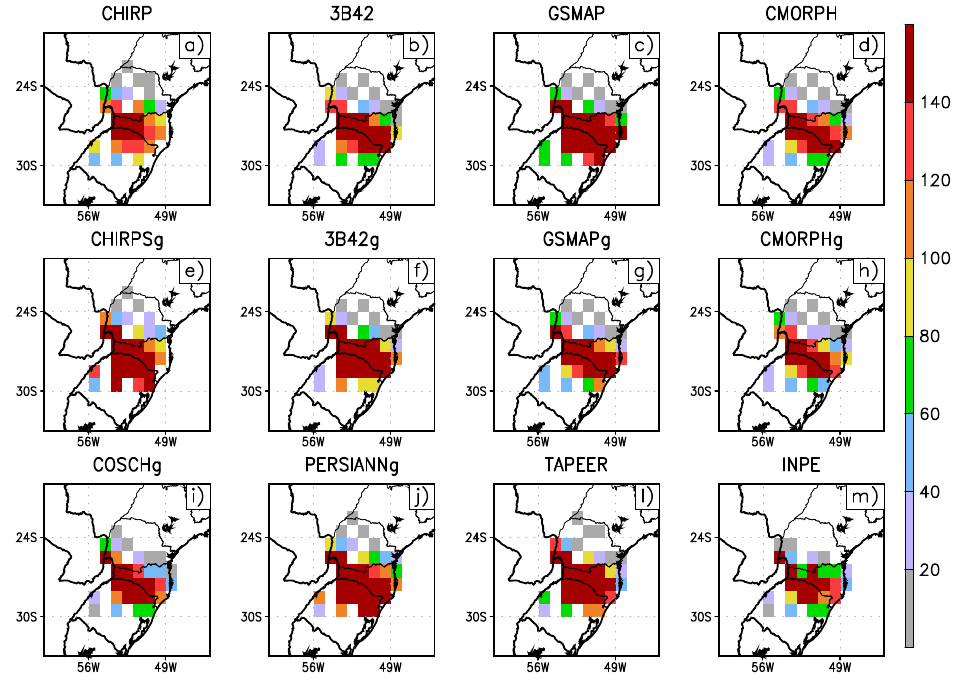
Figure 5. A case of extreme precipitation occurred over the south region of Brazil (R1) from 24 June 2014 to 28 June 2014 estimated by different products ( a – m